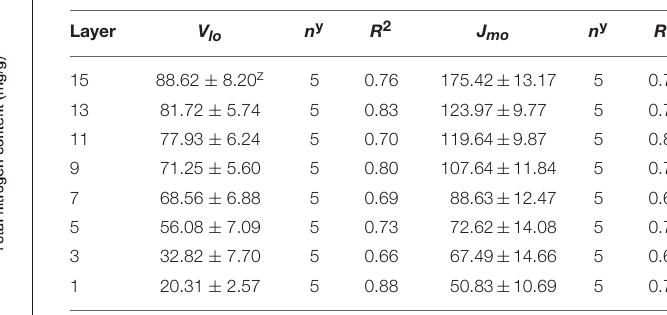
TABLE 4 | Estimation of the photosynthetic parameters V lo ( = value of V l at 25 ◦ C) and J mo ( = value of J m at 25 ◦